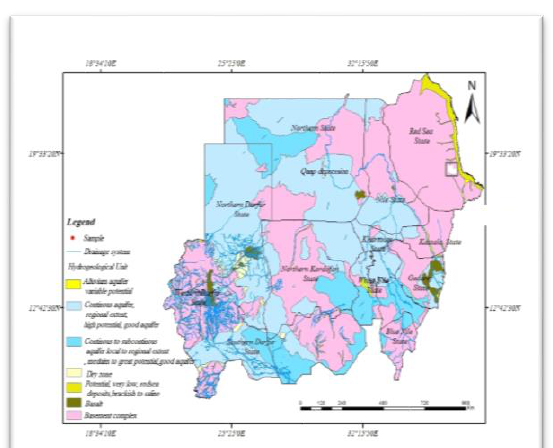
Fig 2. Sudan hydro Geological map show, Khartoum and N. Kordofan state